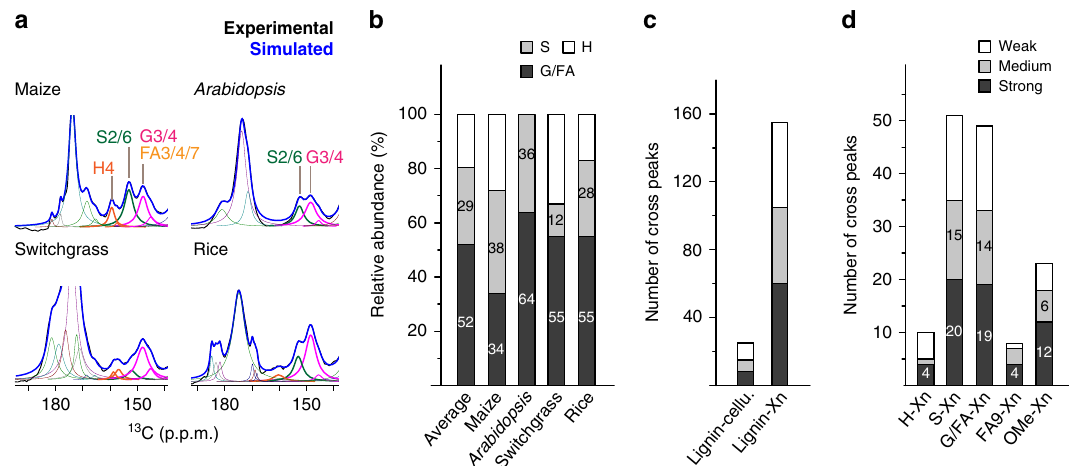
Fig. 3 Lignin composition and carbohydrate interactions in four species. a Spectral deconvolution of quantitative 13 C spectra for compositional analysis of lignin. b The molar composition of lignin from different species. Note that the FA/G is only G in Arabidopsis . c Summary of lignin-carbohydrate interactions. Lignin mainly interacts with xylan instead of cellulose. d The 155 xylan-lignin cross peaks categorized by the lignin type and peak intensities. Source Data are provided as a Source Data fi le for Fig. 3b –